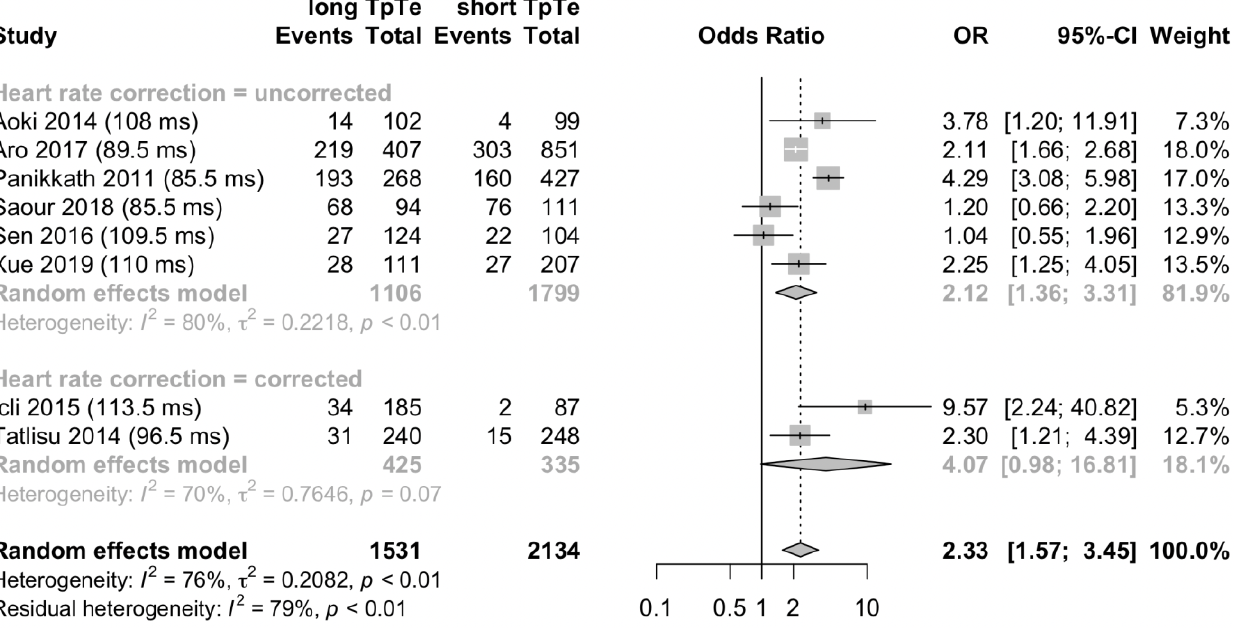
Figure 4. A long T peak -T end interval is associated with all-cause death. The forest plot shows the data from 3665 patients from eight studies, comparing long and short T peak -T end interval in deaths and the total number of patients with the respective T peak -T end interval. Classification in long and short T peak -T end interval was adopted from studies according to the reported cut-off value. A long T peak -T end interval is associated with death by an odds ratio (OR) of 2.33. TpTe = T peak -T end interval; OR = odds ratio; CI = confidence interval [26,27,33,39,47,48,51,54].